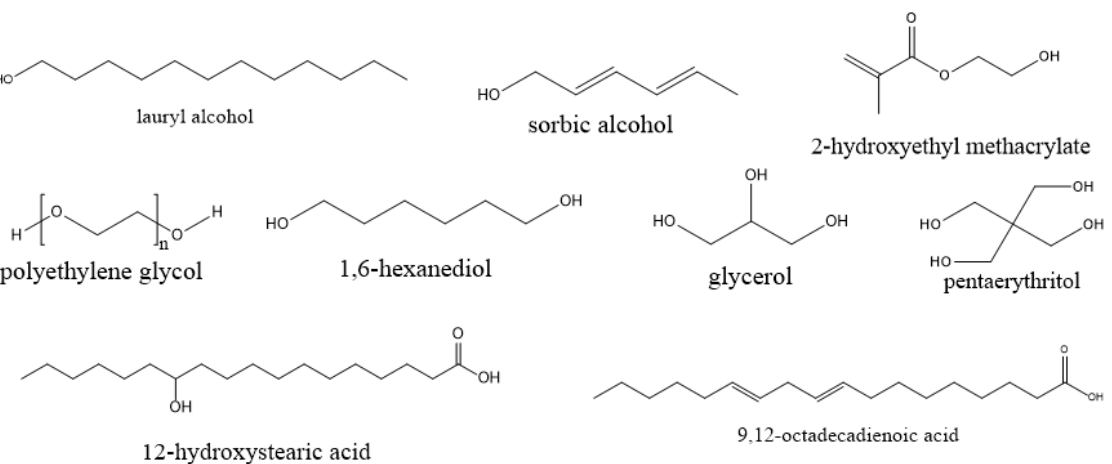
Figure 4. Typical examples of co-monomers used in enzyme-catalyzed polymerization of azelaic acid.